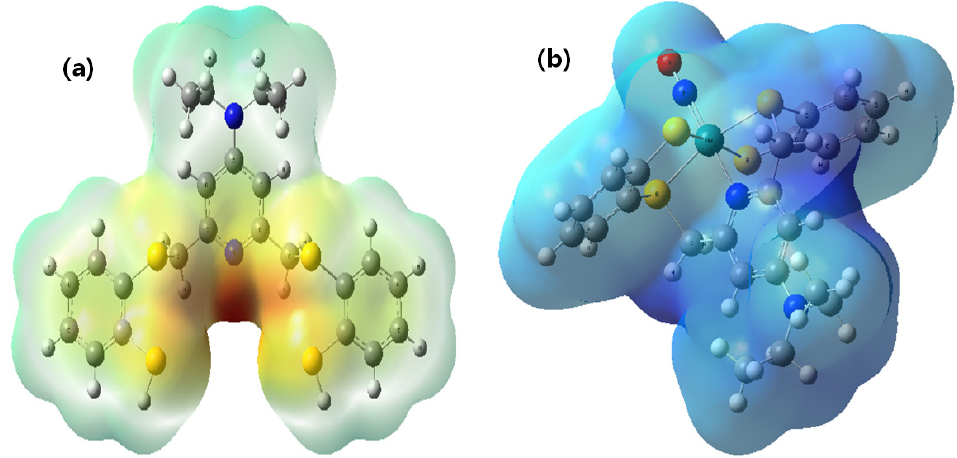
+ 2 and ( b ) [RuNOTSP]